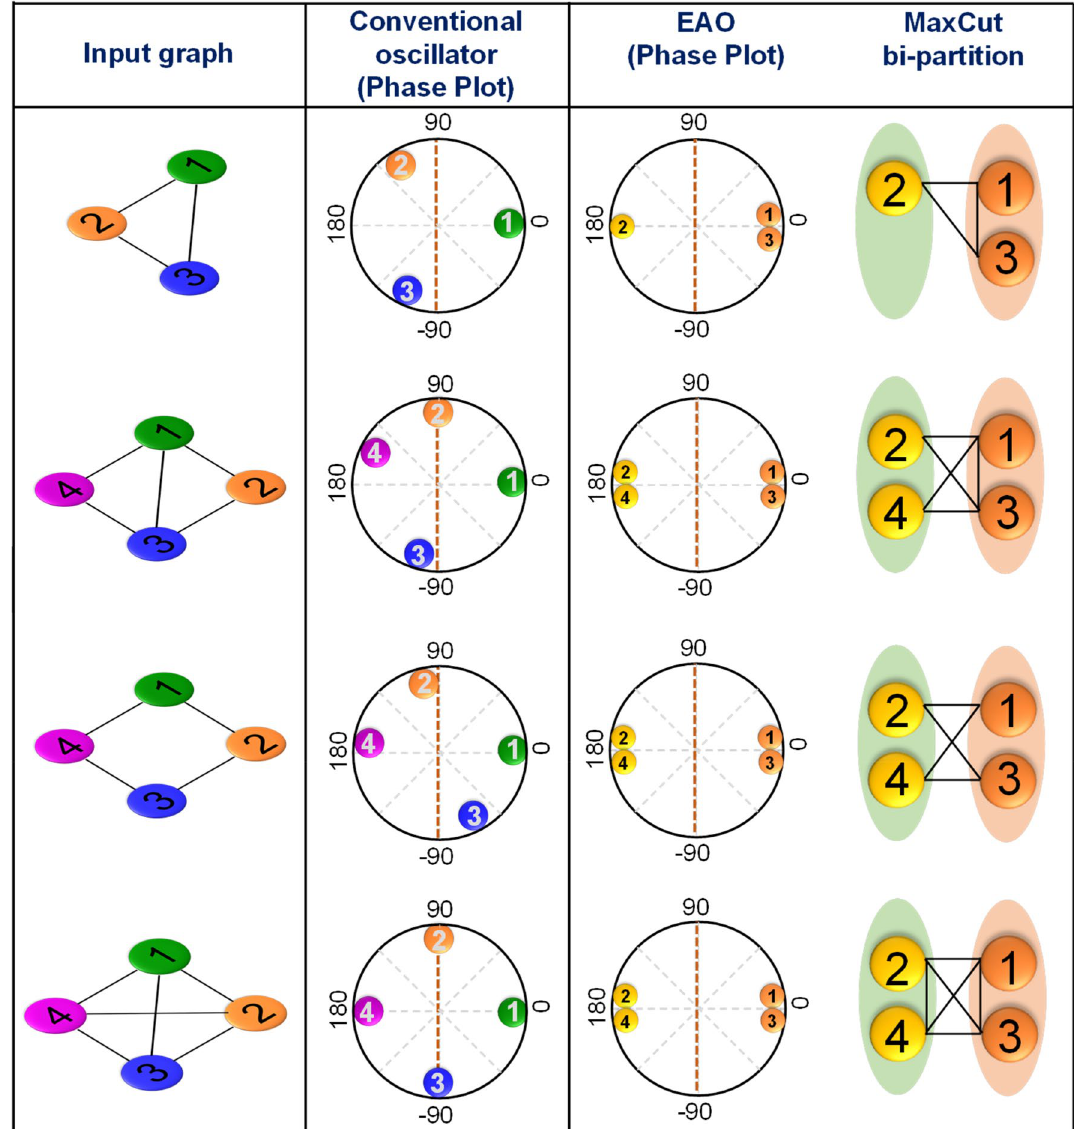
Figure 4. Solving MaxCut using coupled EAOs. Experimentally measured MaxCut solutions for various graph instances obtained using coupled EAOs. The coupled EAOs exhibit a phase bipartition and compute the MaxCut without the need for external second harmonic injection. Corresponding phase dynamics obtained using networks of conventional oscillators (without second harmonic injection) are also shown for comparison. It can be observed that the oscillators do not exhibit a phase bipartition in this